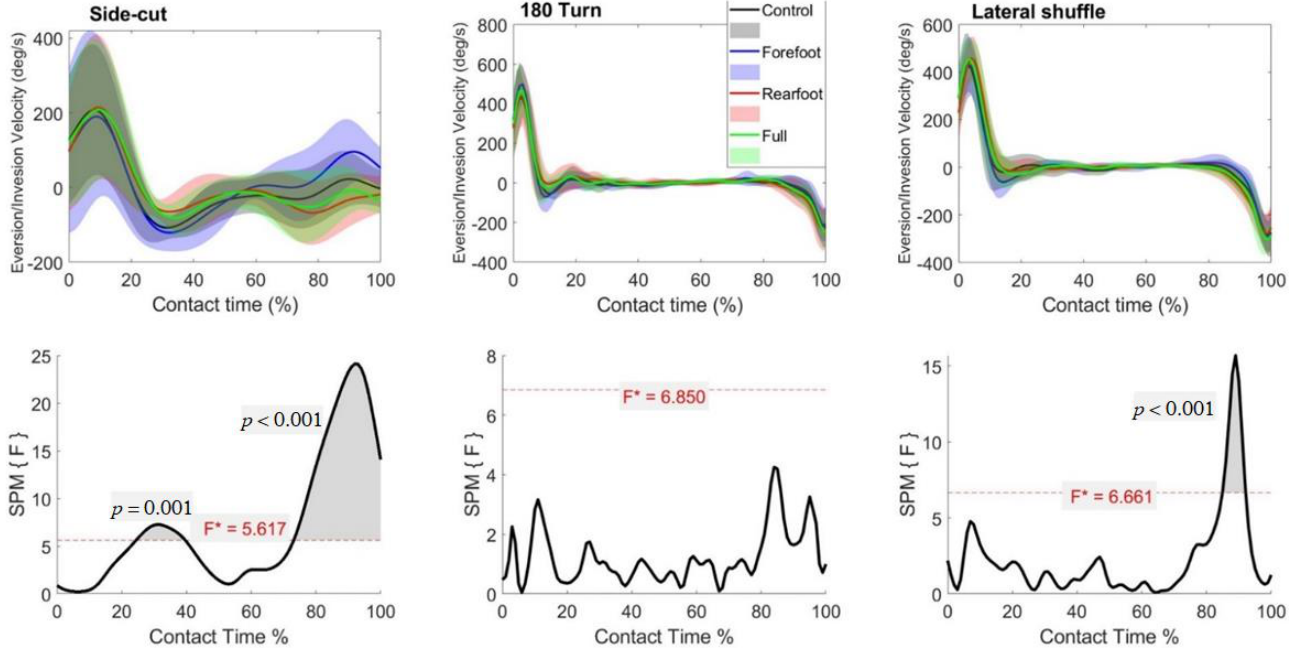
Figure 6. Mean (SD) frontal ankle velocity across participants for each shoe condition (Black = Control, Blue = Forefoot, Red = Rearfoot; Green = Full) ( top ). The SPM(F) values across ground contact time ( bottom ). F* = critical value